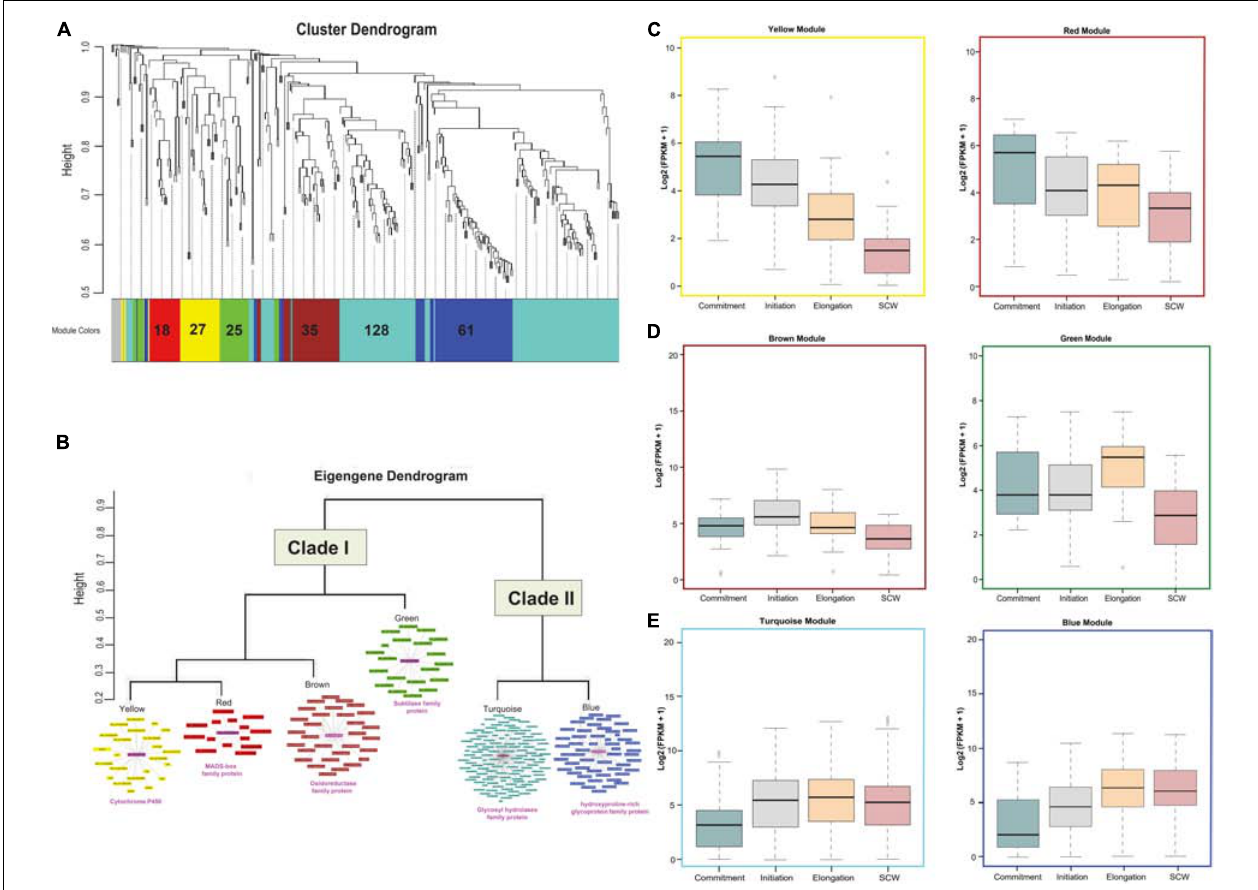
FIGURE 3 | Downstream analysis of upregulated DEGs. (A) Module-specific hierarchical clustering of upregulated genes (302 genes with the log 2fc > 2 and FDR < 0.005) in OF tissue. Different colors represent different modules, and the encrypted number indicates the total number of genes present in those modules. (B) Eigengene dendrogram of six modules that were grouped into two major clades. The co-expression behavior of genes present in each module was visualized through a co-expression network in which the magenta color shows the hub gene. The putative annotation of the hub gene was mentioned below the clade. Functional characterizations of different modules at Commitment, Initiation, Elongation, and secondary cell wall (SCW) fiber developmental stages for (C) yellow and red modules, (D) brown and green modules, and (E) turquoise and blue